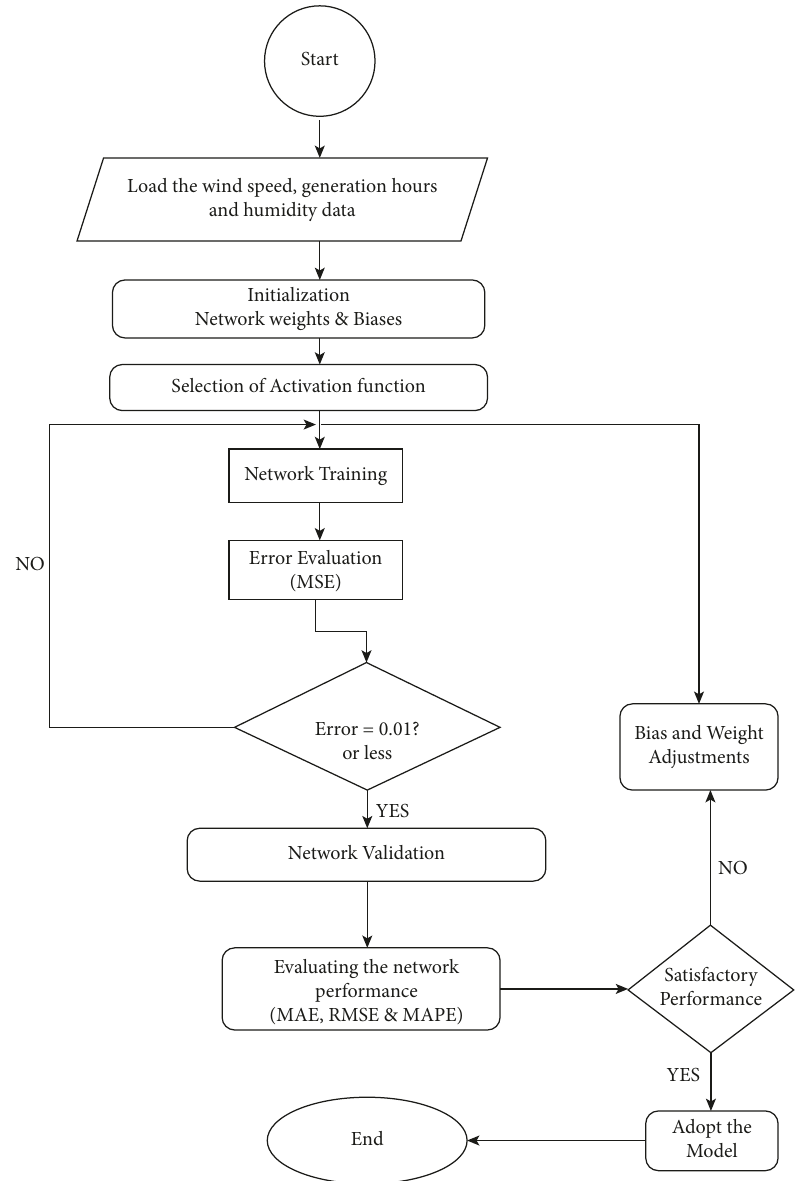
Figure 3: The BPNN training algorithm